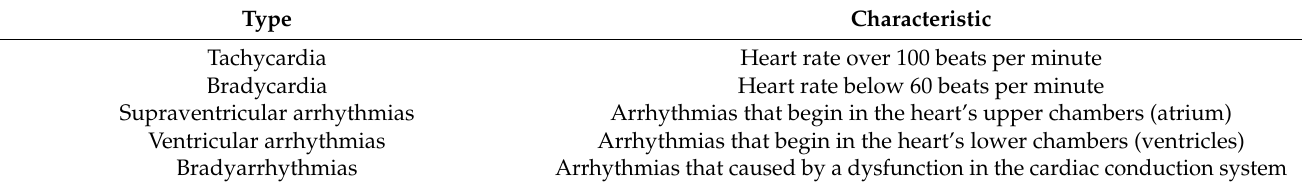
Table 1. The most common types of arrhythmia.